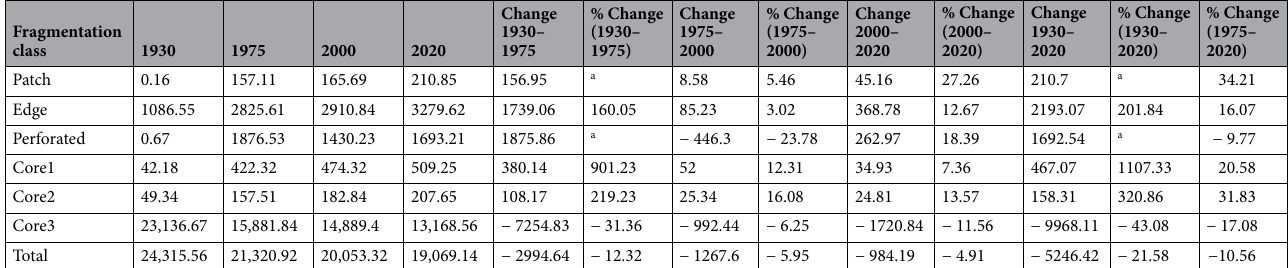
Table 3. Temporal forest fragmentation (area in km 2 ). Change percentage represented by ‘a’ means the highly inflated figure due to very small denominator. a The estimate is not reliable as forest cover within these categories were very small in 1930.